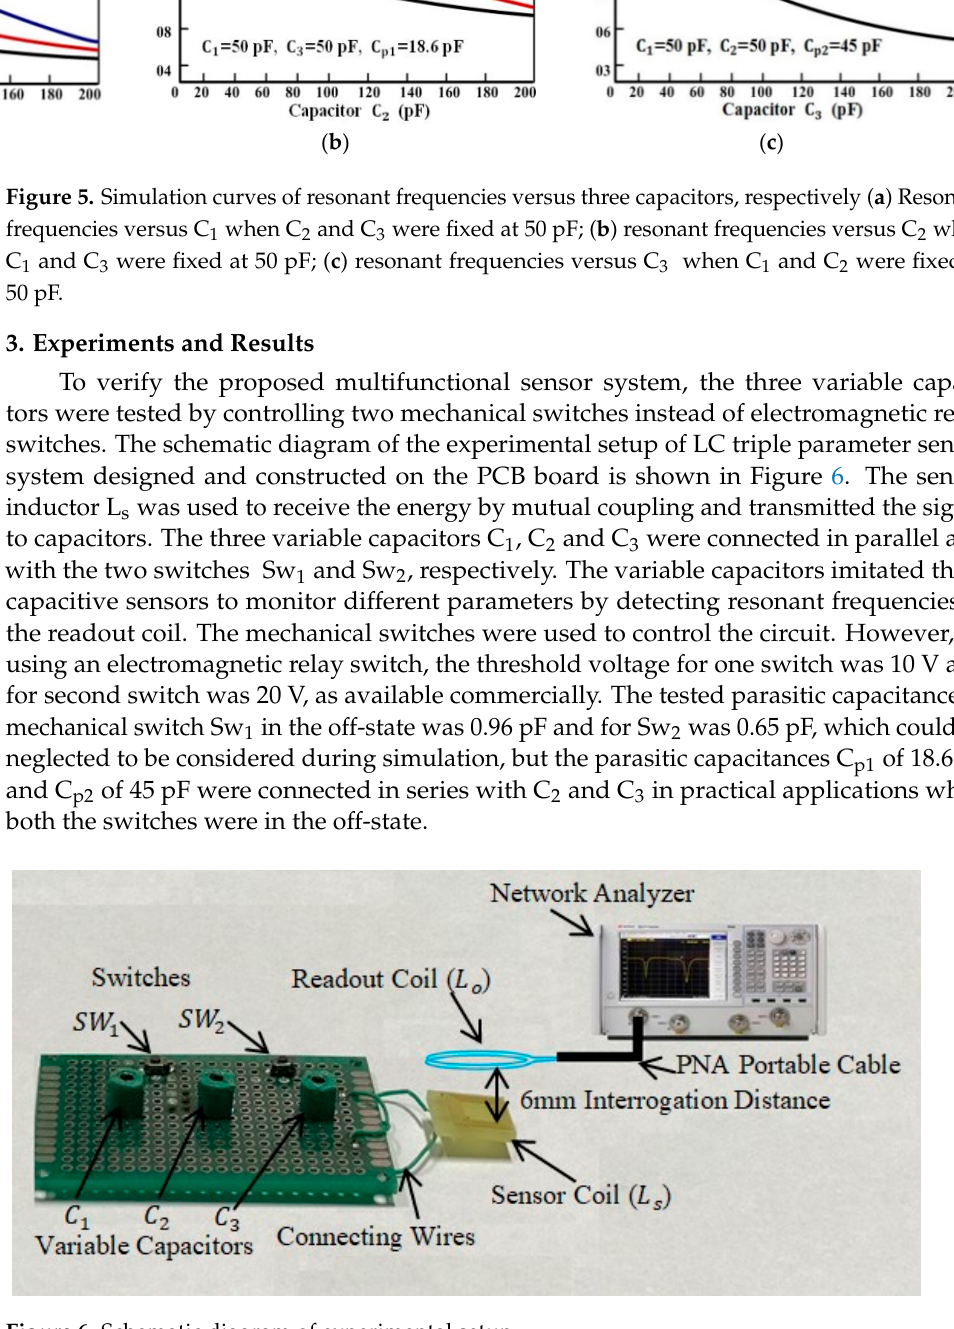
Figure 6. Schematic diagram of experimental setup.